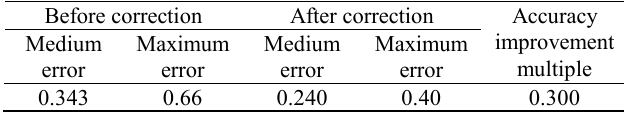
Table 3 Accuracy comparison of Akima curve fitting